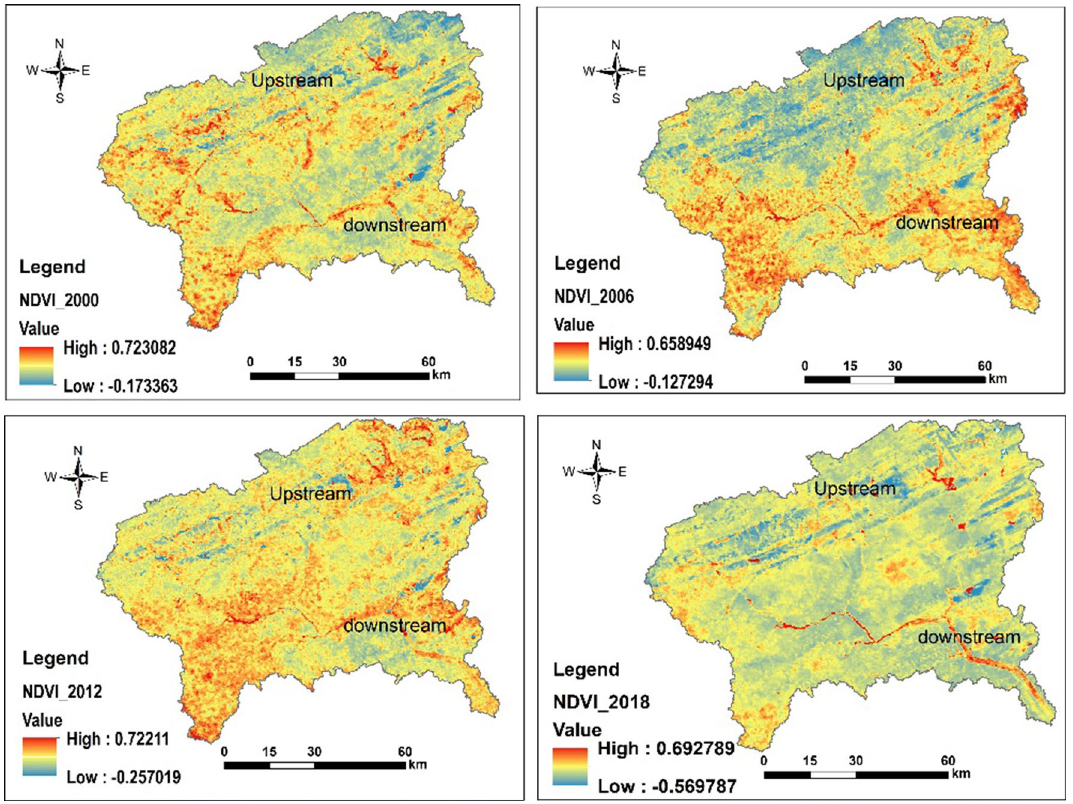
Fig. 3 The changes in growing season NDVI from 2000 to 2018 in Korama basin, Zinder,